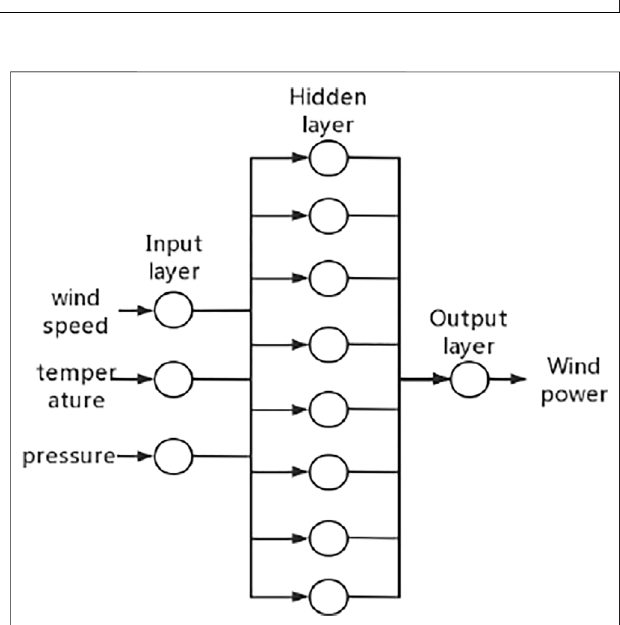
FIGURE 1 | Flow chart of the BP neural network algorithm.